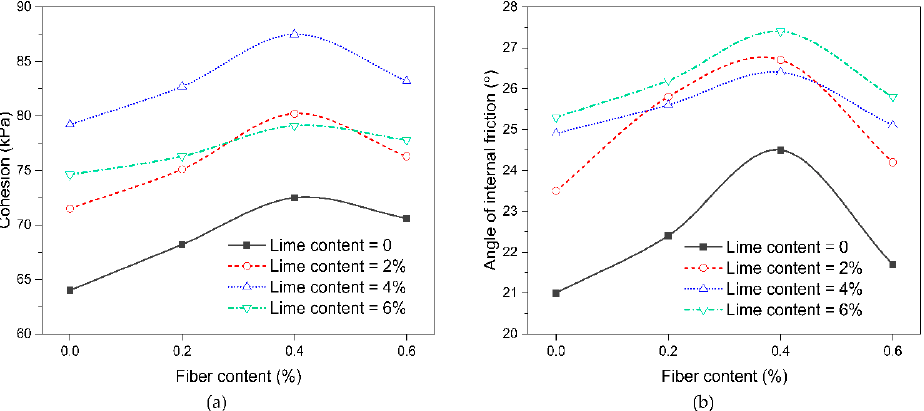
Figure 3. Shear strength parameters for soil samples with additives of different contents: ( a ) cohesion and ( b ) angle of internal friction.